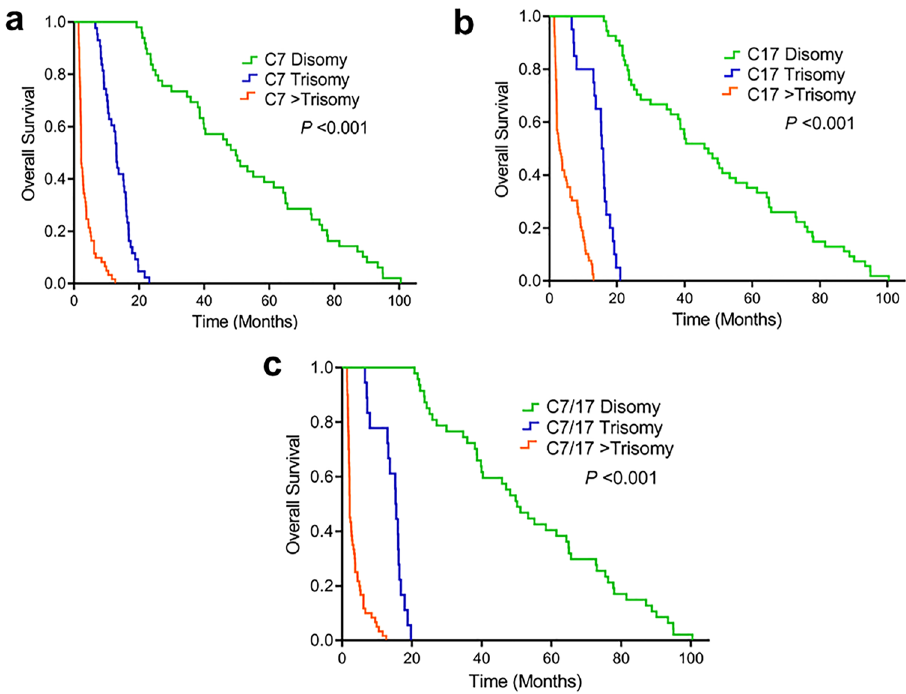
Figure 4. Kaplan–Meier analysis for overall survival time with an increased chromosome 7, 17 and both 7/17 copy number in CCA patients ( a – c ).